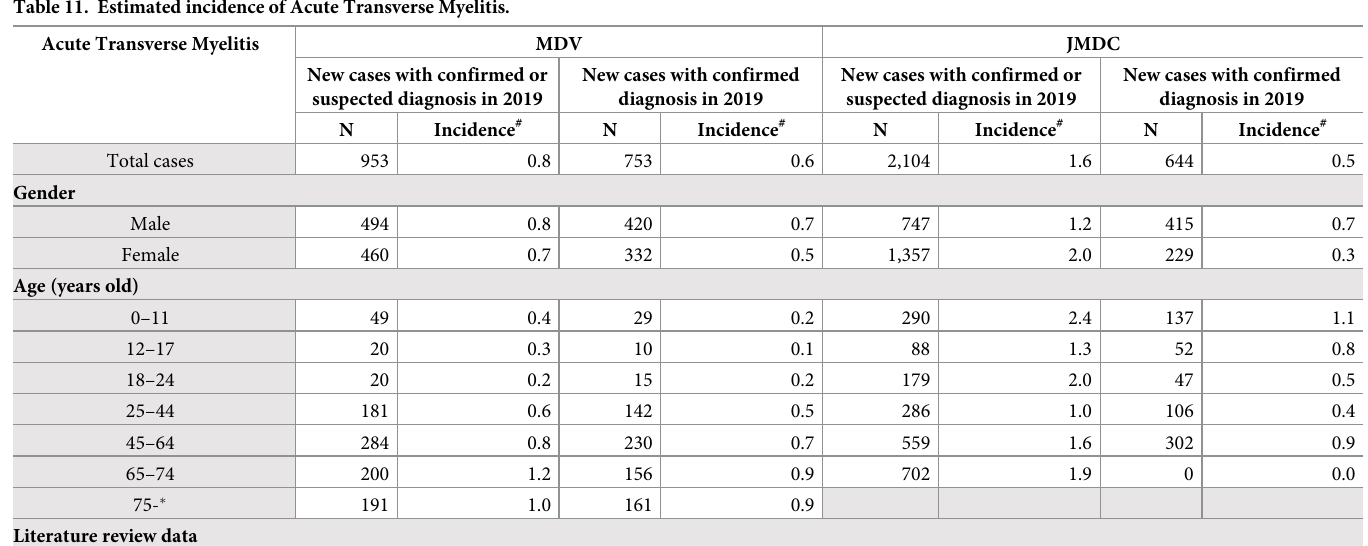
Table 11. Estimated incidence of Acute Transverse